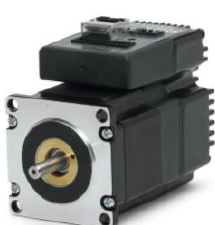
Figure 7. National instruments ISM-7411 stepper motor.